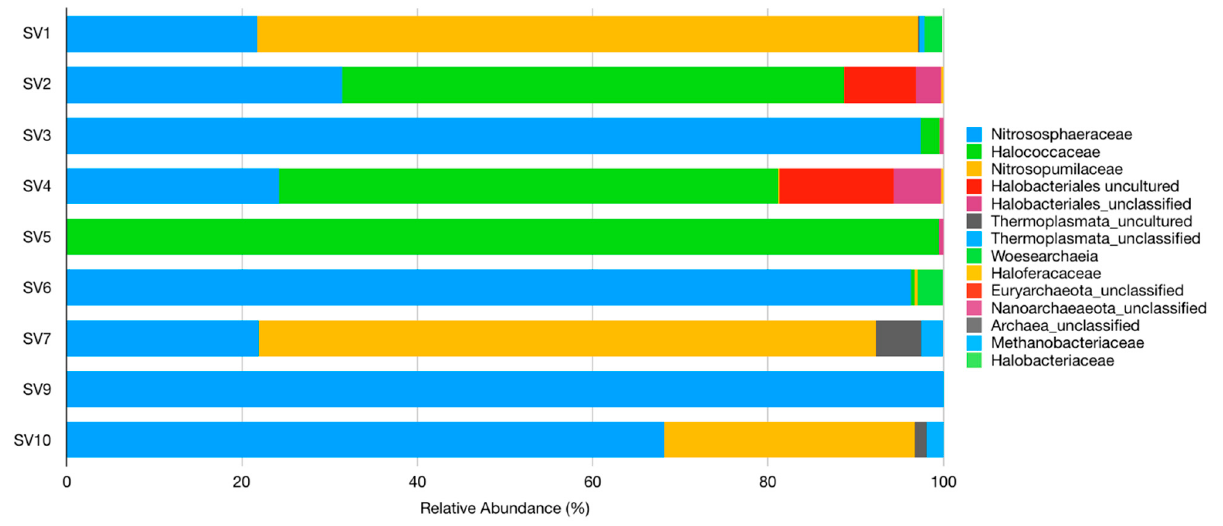
Figure 2. Relative abundance and distribution of archaeal families in each sample.